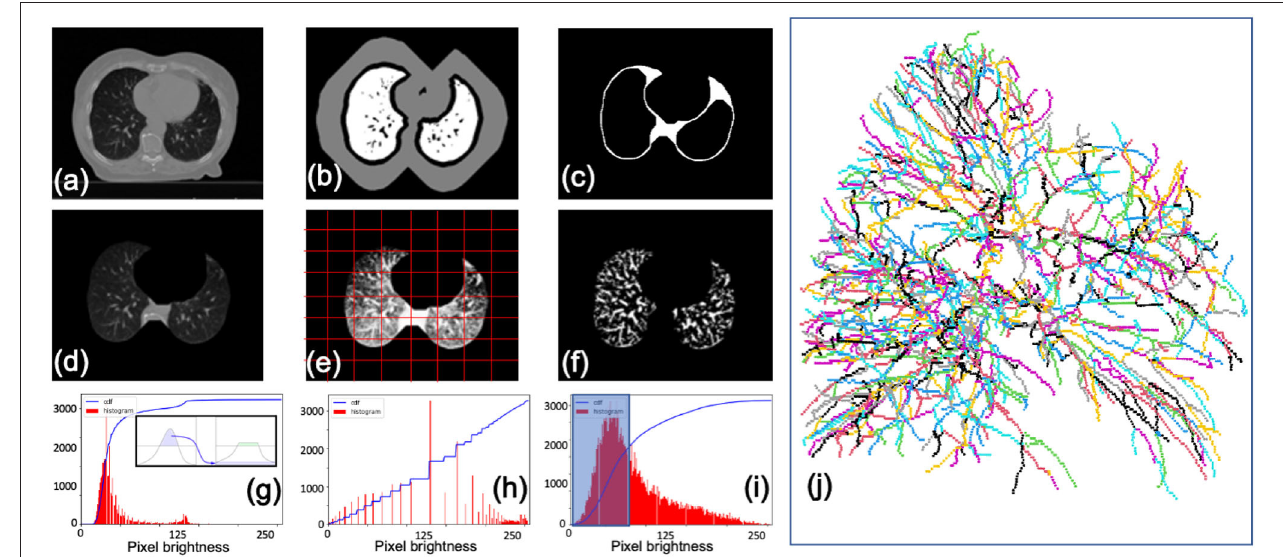
FIGURE 3 | Segmentation procedure for CT scans. (a) Initial image. (b) Lung boundary markers determined using watershed. (c) Mask with boundaries re-included by black top-hat transform. (d) Segmented image. (e) Contrast enhanced image with adaptive mesh (red) overlaid for limited equalization (CLAHE). (f) Final image after enhancement and de-noising via thresholding. Examples of pixel brightness histograms prior to enhancement (g) , after enhancement (h) , and with a de-noising filter (i) . (j) Left lung vessel skeletonization output from Angicart following steps described previously. Vessels are colored by canonical generation labeling (see Figure 4 ).